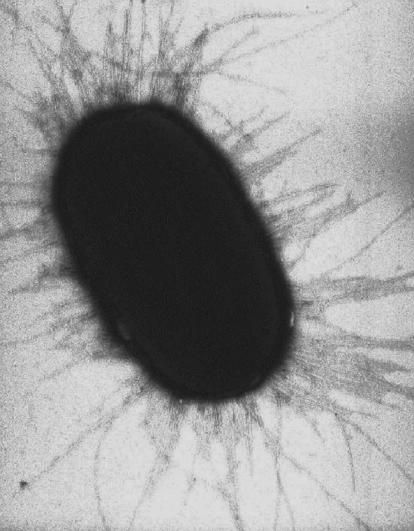
The long, sticky filaments covering E. coli bacteria uncoil under force, apparently improving the binding of the terminal adhesive unit in the presence of forces generated by fluid flow. (Image: Manu Forero)